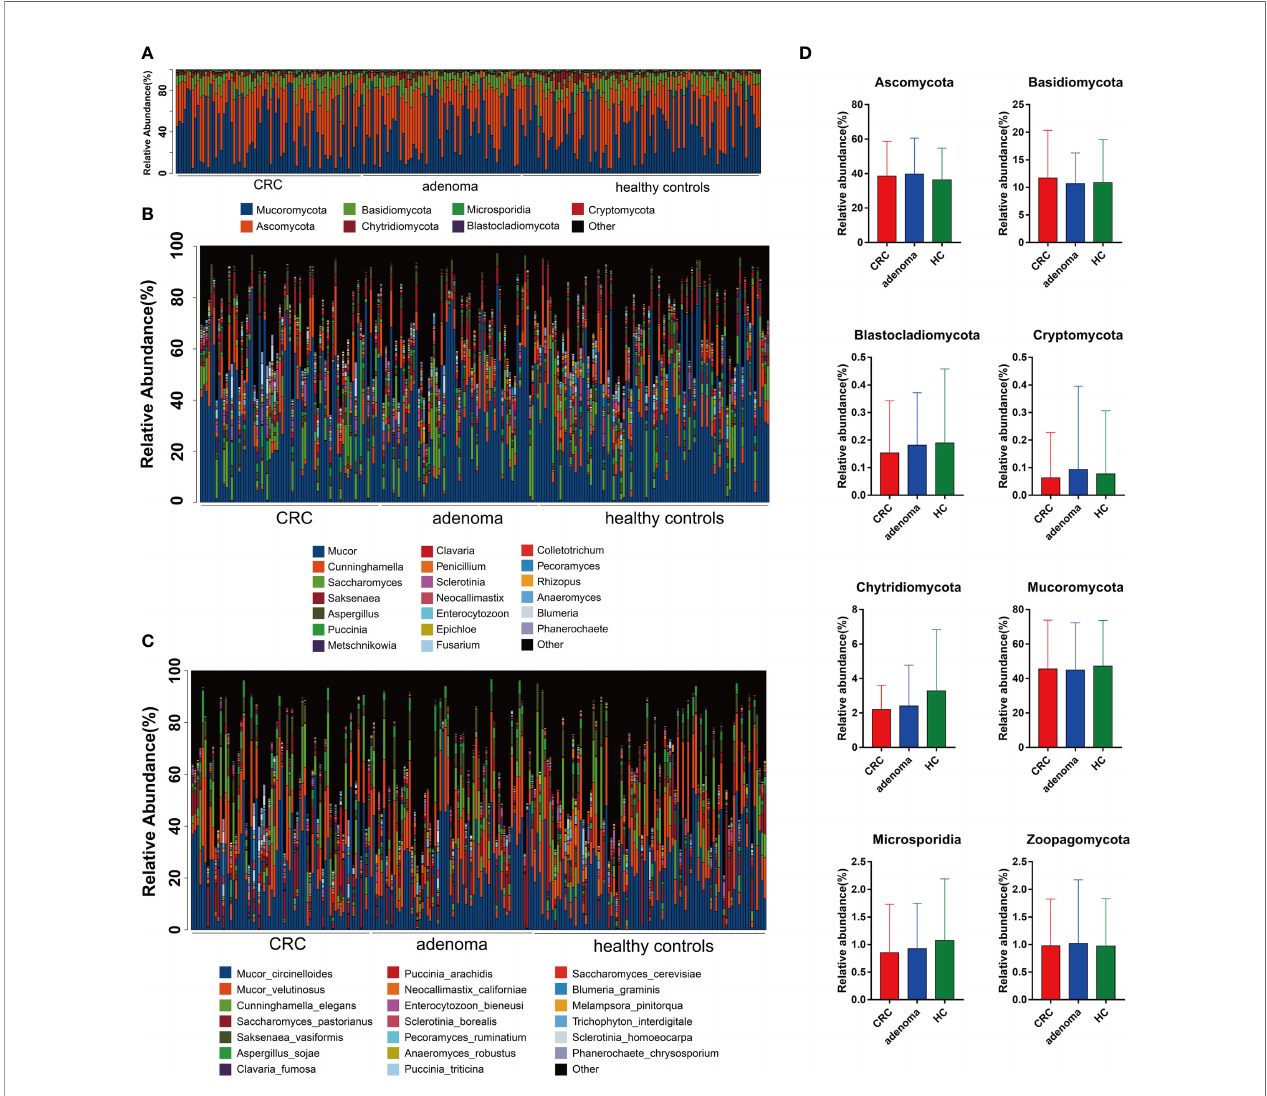
FIGURE 2 | The taxonomy of gut mycobiota at the phylum (A) , genus (B) , and species (C) levels in colorectal cancer (CRC), adenoma, and healthy controls. The comparisons of eight mycobiota at the phylum level in CRC, adenoma, and healthy controls (HC) (D) . No signi fi cant changes were found between the three